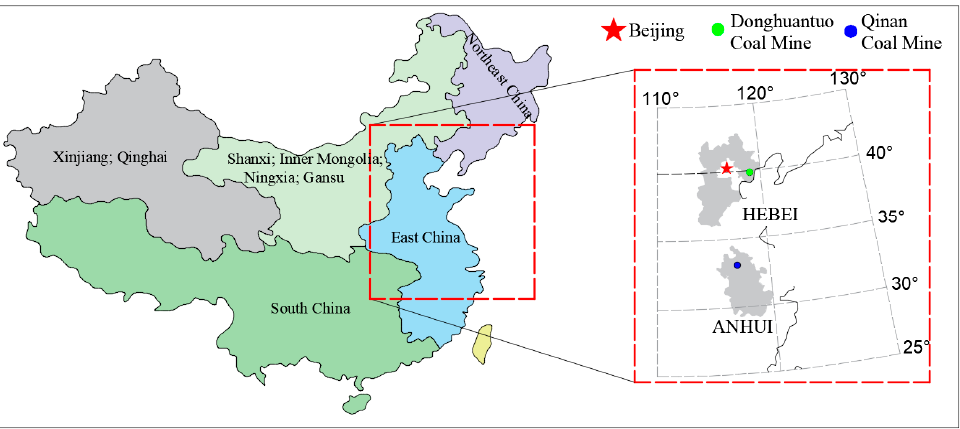
Figure 1. Two studied coal mines in East China.